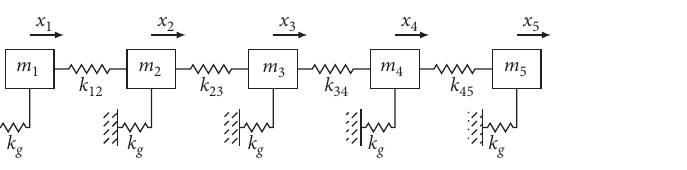
Figure 2: Test-case 1: sketch of the five-mass system. Table 2: Test-case 1: original and modified system design variables and constraints.